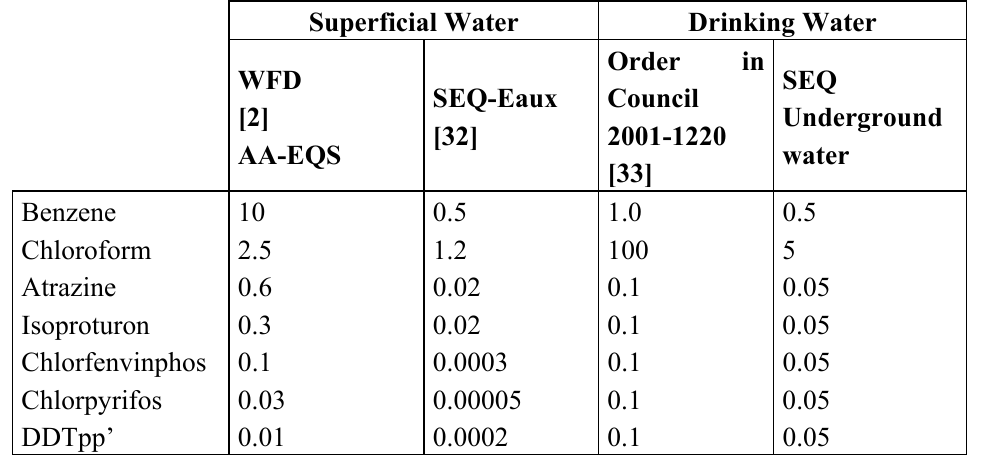
Table 10. Summary of the superior limit concentrations (µg/L) in organic substances, recommended or statutory in